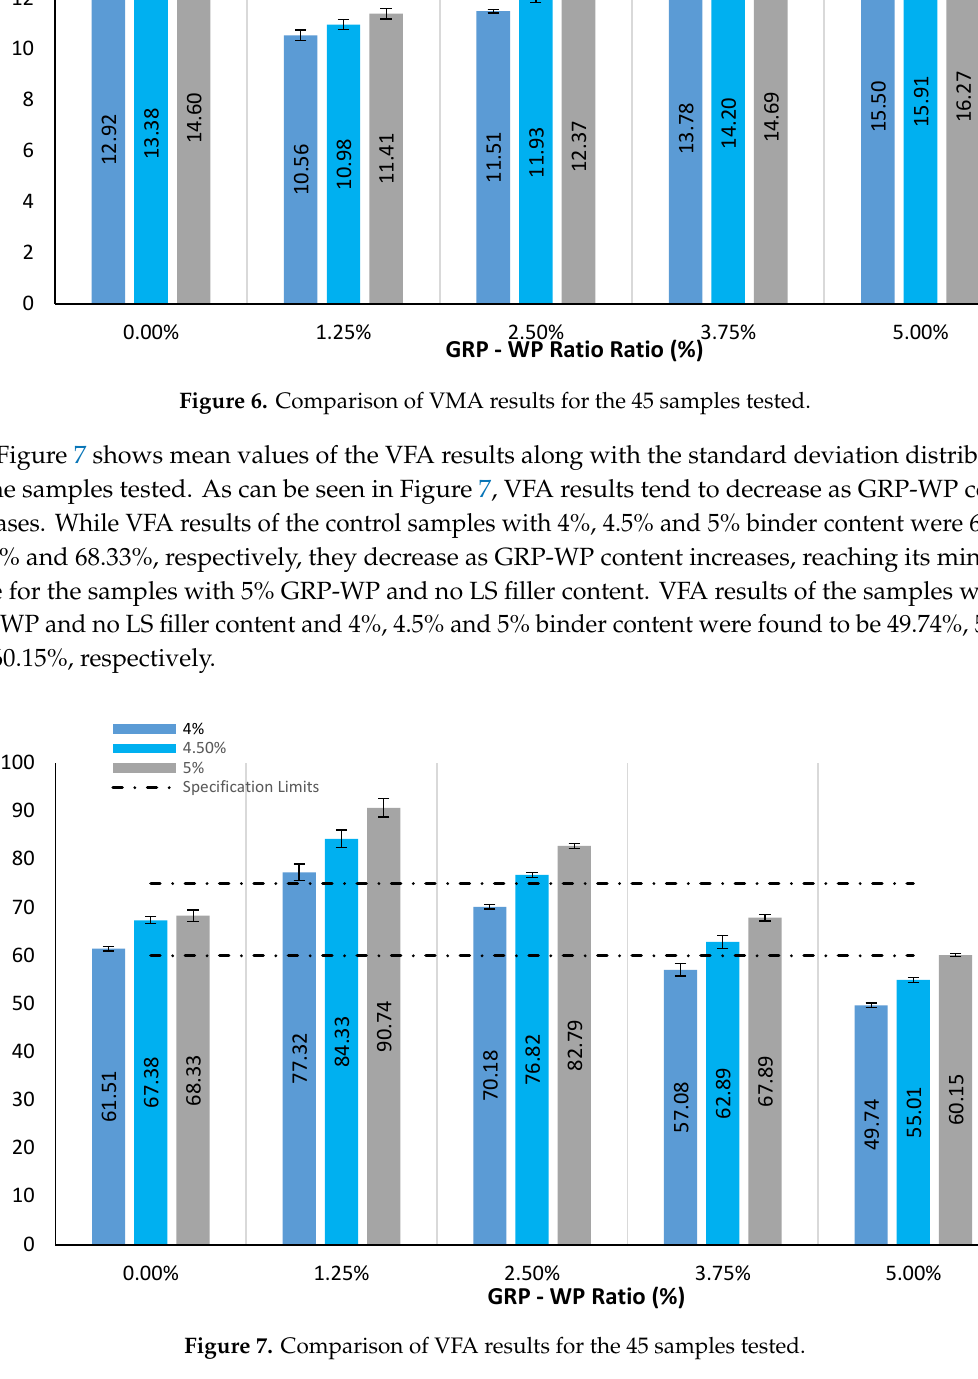
Figure 5. Comparison of flow results for the 45 samples tested. Figure 6 shows mean values of the VMA results along with the standard deviation distributions for the samples tested. As can be seen in Figure 6, VMA results were found to increase as GRP-WP content increased. While VMA results of the control samples were in the range of 12.92% to 14.60%,